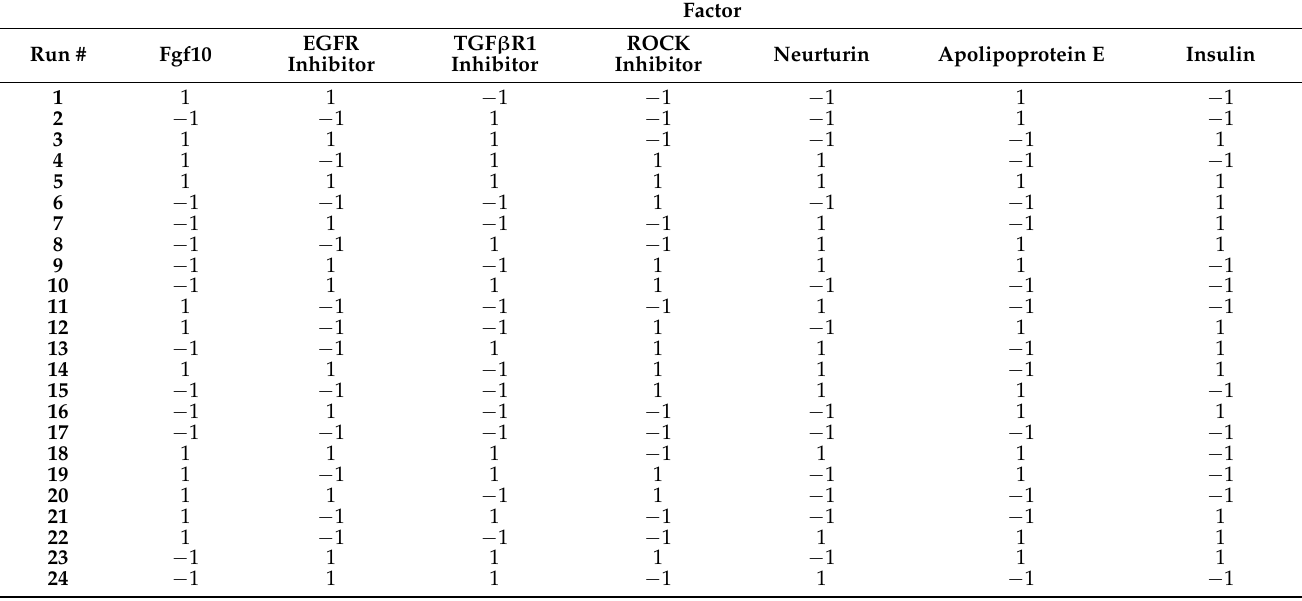
Table 2. Experimental Design for the Plackett–Burman DoE Created using JMP. Each Row (Run) Indicates an Independent Experiment with the Factors Present At the − 1 or +1 Level as Indicated. Concentrations for These Levels are Shown in Table 1.